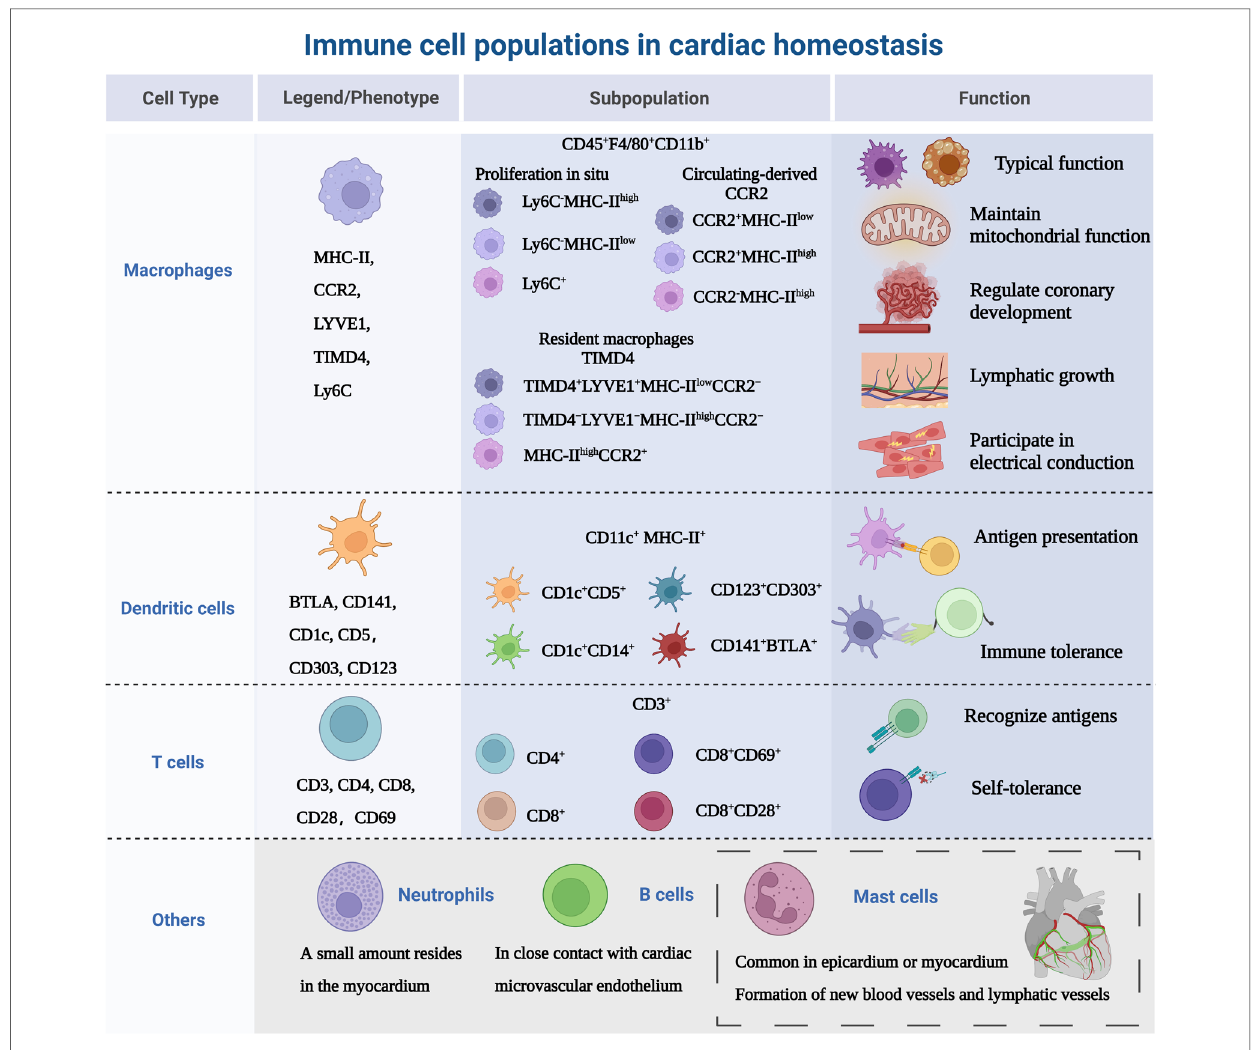
FIGURE 2 Immune cell populations in cardiac homeostasis. The study of immune cells in the absence of disease or homeostasis in the heart is equally important. Because immune cells are not “ visitors ” of the heart, they are the early components of the heart, not only in terms of immunity, but also involved in the growth and development of the heart. MHC-II, major histocompatibility complex class II; CCR2, CC-chemokine receptor 2; LYVE1, lymphatic vessel endothelial receptor 1; TIMD4, T cell immunoglobulin and mucin domain containing 4; Ly6C, lymphocyte antigen 6C; BTLA, B- and T-lymphocyte attenuator. Created with